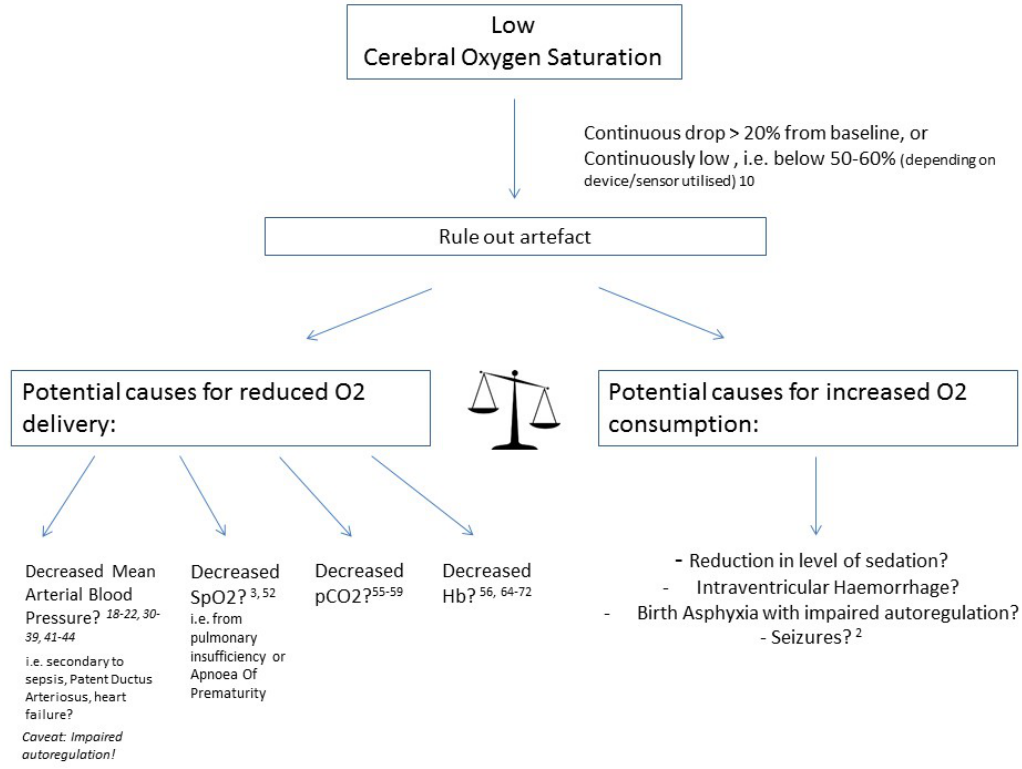
Figure 1. Causes of low cerebral oxygen saturation.